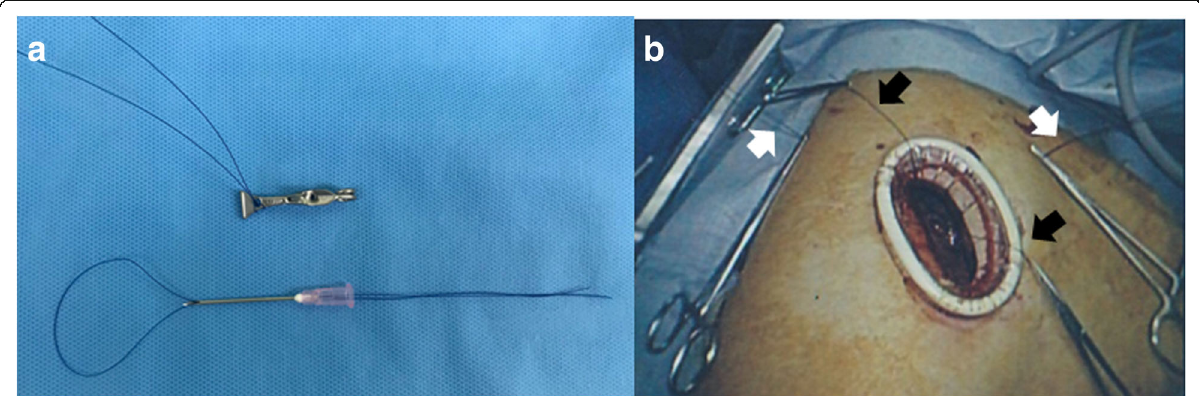
Fig. 2 Preparation of the modified marionette technique. a The IOR with a 1-0 nylon thread (top) and a looped 1-0 nylon-threaded 18-gauge injection needle (bottom). The 1-0 nylon ligated the IOR through the hole existing at tips of the IOR for proper retraction. b Intraoperative view. Mosquito forceps grasp 1-0 nylon threads pulled out from thoracic cavity. White arrows indicate looped 1-0 nylons working as pivots. Black arrows indicate 1-0 nylons attached to the IOR